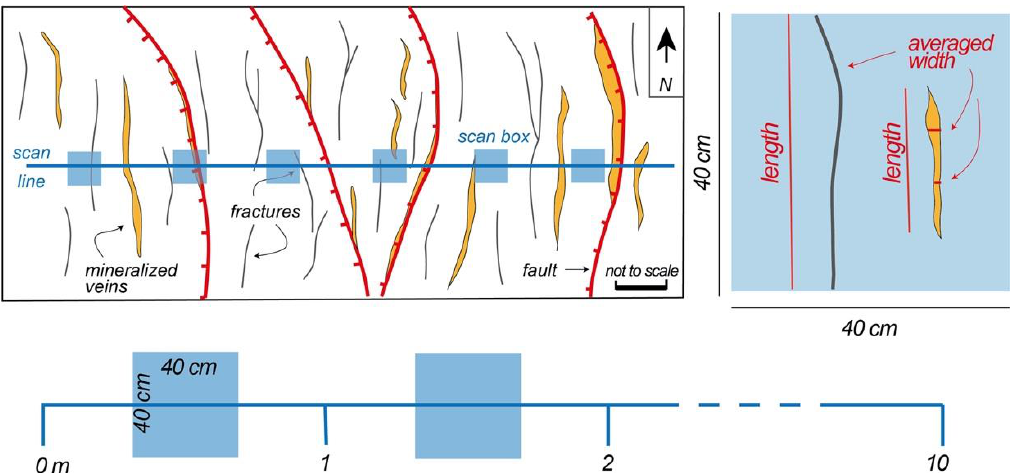
Figure 5. Sketch illustrating the methodology of scan line and scan box to collect data for the computation of permeability, considering width and length of fractures and veins, as recognized in a square of 40 cm per side. The scan line is settled after a detailed geological survey in the chosen key-area: along the line, the frequency of fractures is considered. The scan box is moved aside regularly along the scan line and data are collected (manually or by analyzing photos by image software) in each new location of the scan box.